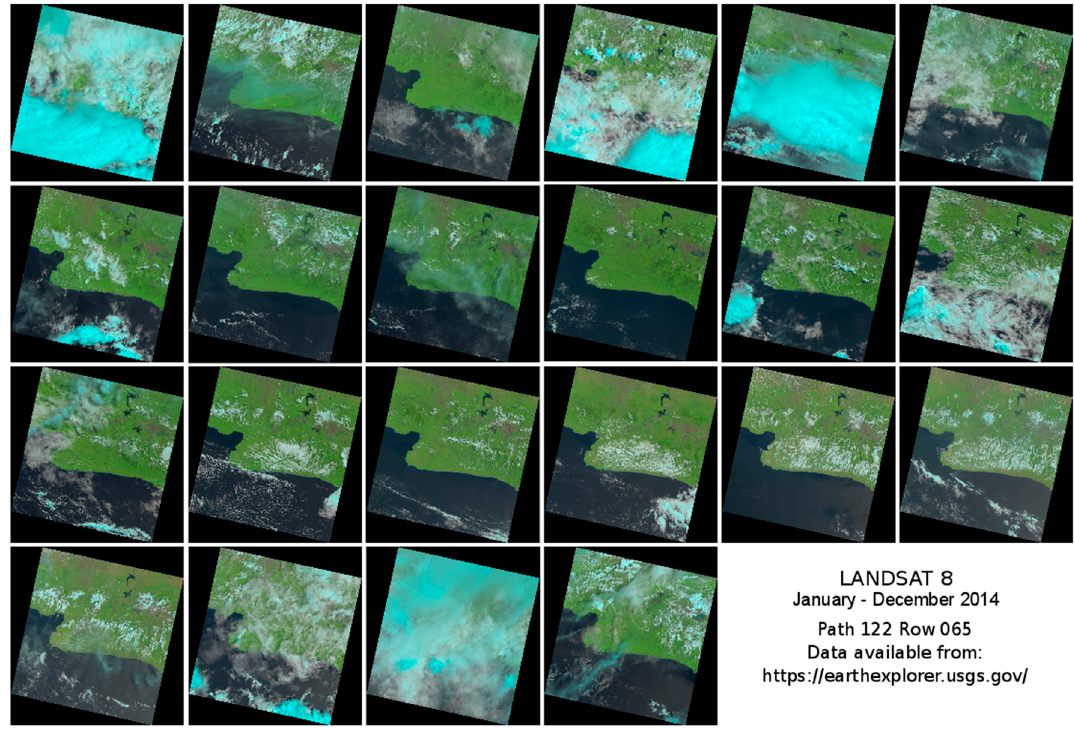
Figure 1. Visual condition of all available Landsat 8 images for Path 122 Row 065, during 2014. Cloud cover affects many of the images.